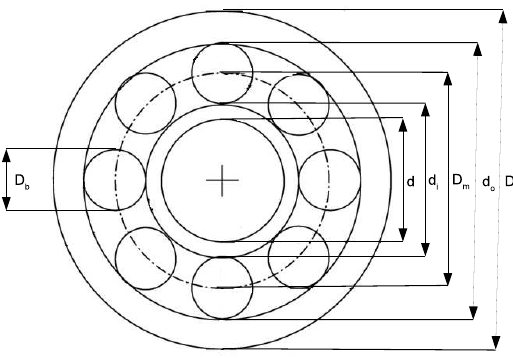
Figure 10. Rolling element bearing design problem.